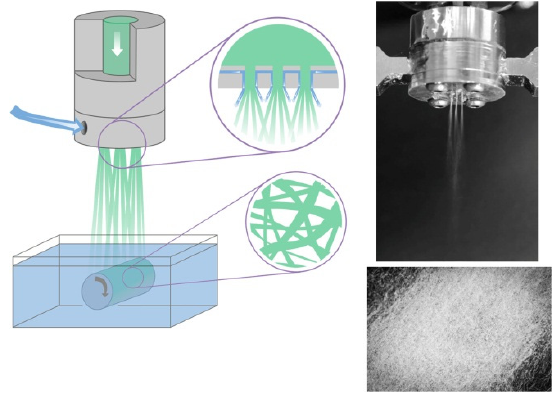
Figure 7. Dry-wet solution blow spinning of cellulose fibers from solution in ionic liquid (reprinted from reference Jedvert, K.; Idström, A.; Köhnke, T.; Alkhagen, M. Cellulosic nonwovens produced via efficient solution blowing technique. J. Appl. Polym. Sci . 2020 , 48339 , 1–9). Dissolved cellulose pulp in ionic liquid 1-ethyl-3-methylimidazolium acetate (EMI-